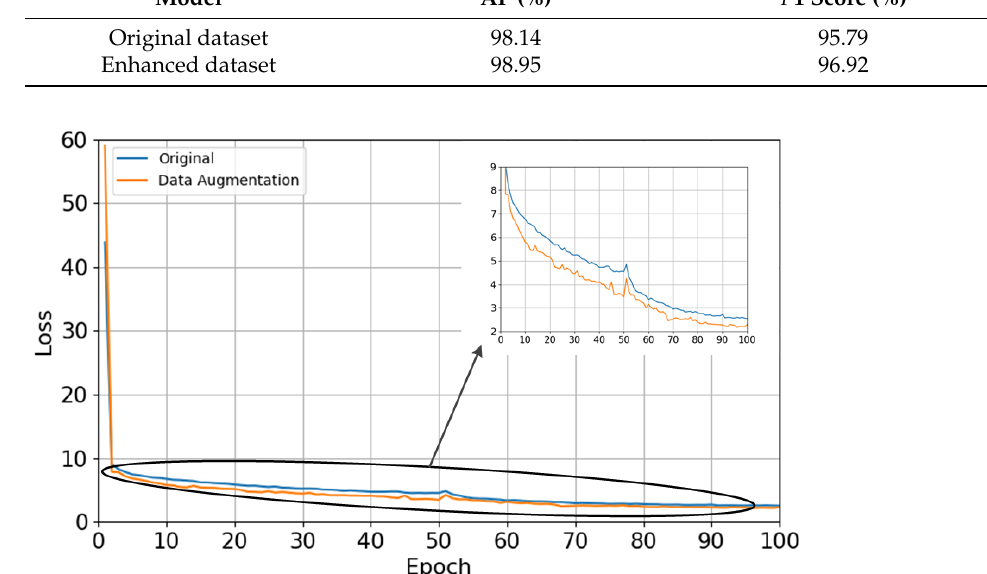
Figure 14. YOLO-SC model loss curves for both datasets (top right is a magnification of the circled portion